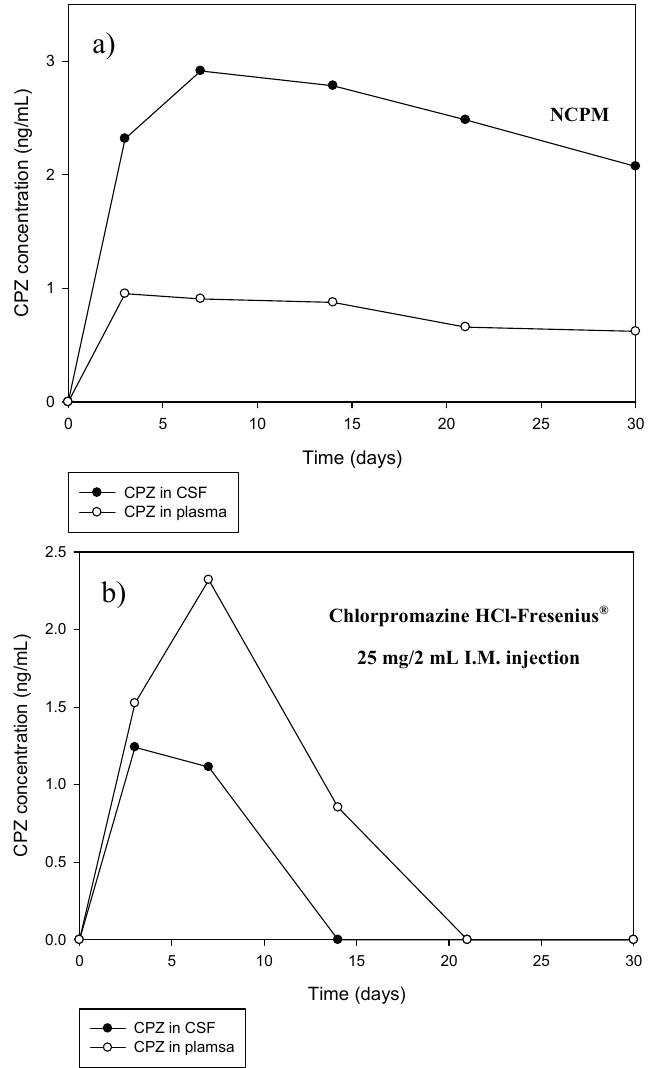
Figure 19. In vivo CPZ release from ( a ) the NCPM and ( b ) the commercially available Chlorpromazine HCl-Fresenius ® 25 mg/mL (SD ≤ 0.31 in all cases). The intramuscular dose of CPZ (Chlorpromazine HCl-Fresenius ® 25 mg/mL) revealed higher levels of CPZ in the blood plasma when compared to the CSF. This is due to the extremely low